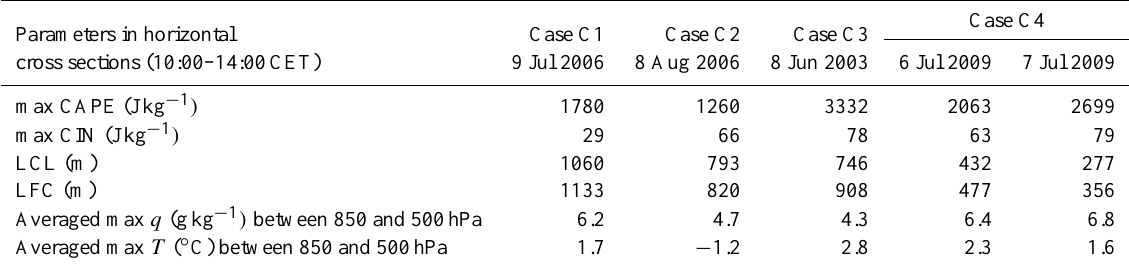
Table 3. Thermodynamical variables over the Istria peninsula for four selected cases. In the table, abbreviations represent: CAPE: convective available potential energy, CIN: convective inhibition, LCL: lifting condensation level, LFC: level of free convection. Max CAPE, max CIN, LCL and LFC are calculated for the parcel in each grid point with maximum equivalent 2 below 3000ma.g.l. Hourly maximum values of max CAPE, max CIN and hourly minimum values of LCL and LFC were averaged between 10:00 and 14:00CET. From vertically averaged mixing ratio ( q ; gkg − 1 ) and air temperature ( T ; ◦ C) in the layer of 850–500hPa, hourly maximum q and T values (over the peninsula) were averaged in time, between 10:00 and